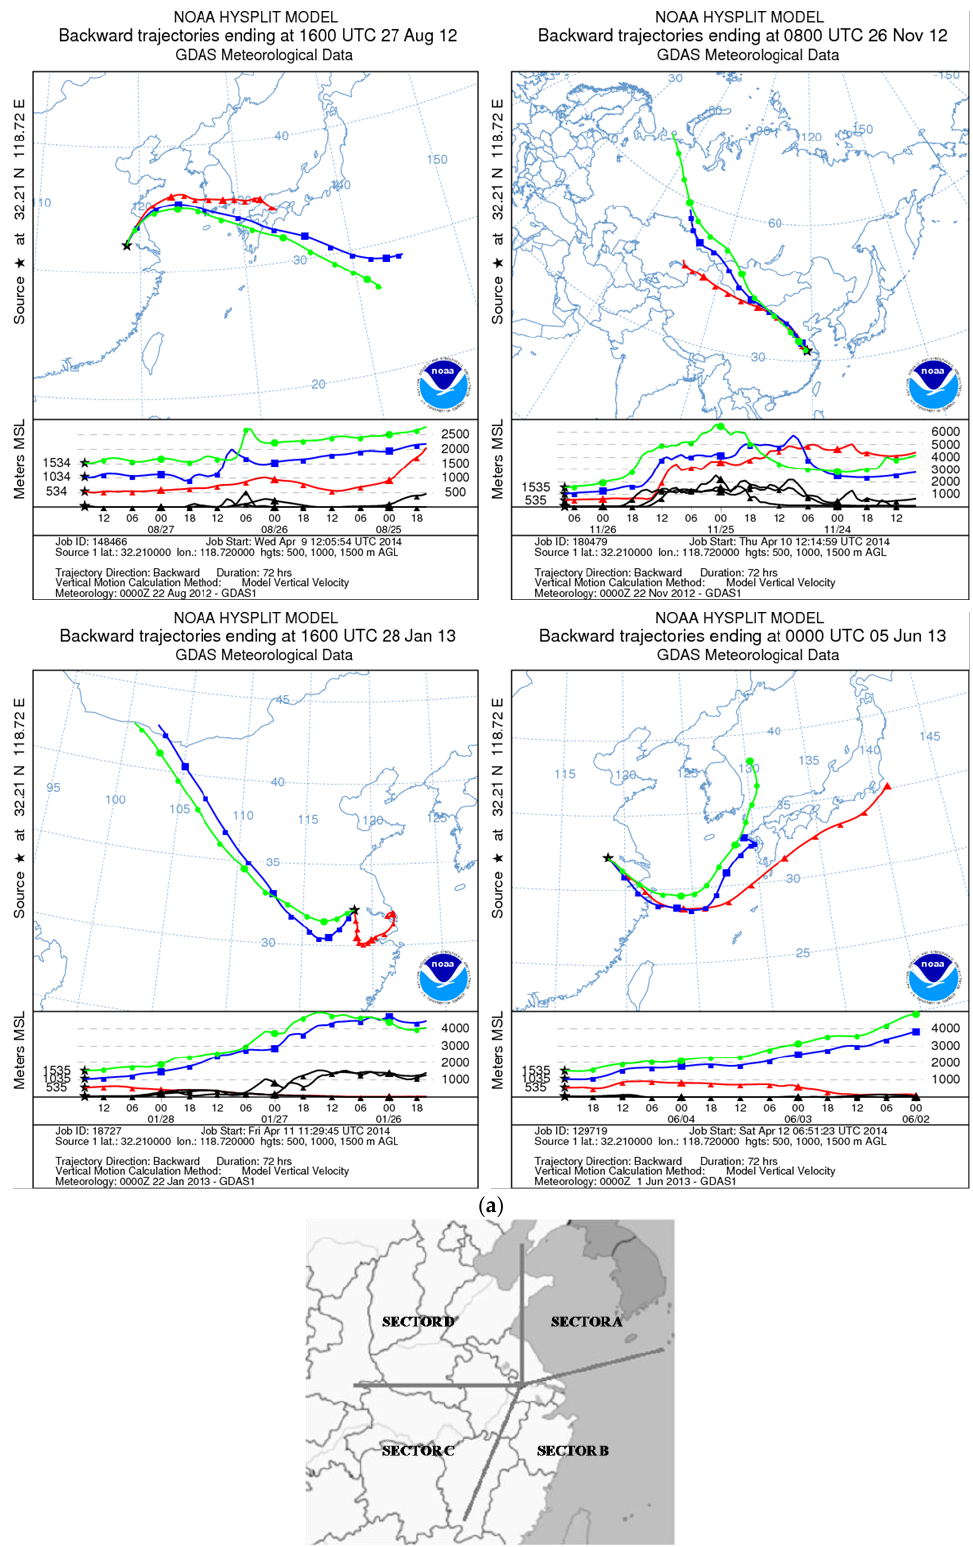
Figure 4. Hybrid Single-Particle Lagrangian Intgrated Trajectory (HYSPLIT) back trajectories showing the paths of the aerosol parcel during the sampling period; ( a ) back trajectories in four seasons; ( b ) Air parcel trajectory sectors.